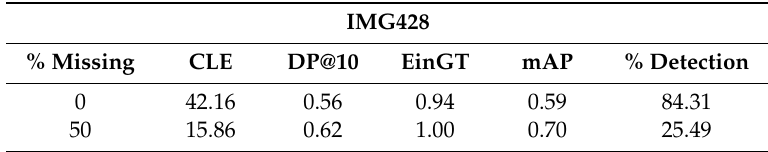
Table 3. Performance metrics for 0 and 50 percent missing pixels. JHU fire escape scenario: Video